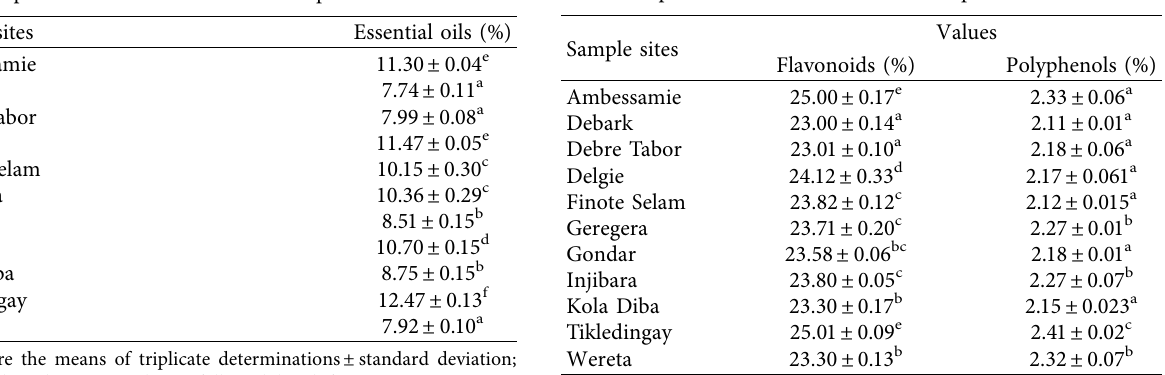
Table 3: Average concentration of antioxidants of R. prinoides leaves samples collected from different sample